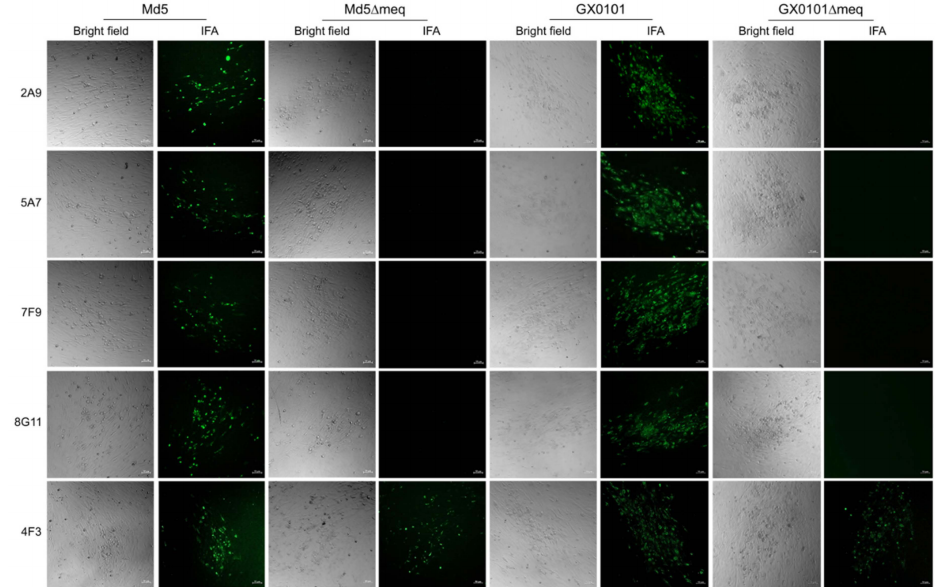
Figure 2. Cross screening and identification of Meq-specific antibodies by immunofluorescence assay. Plaques produced in CEFs by the infection with parental or Meq-deleted viruses were stained